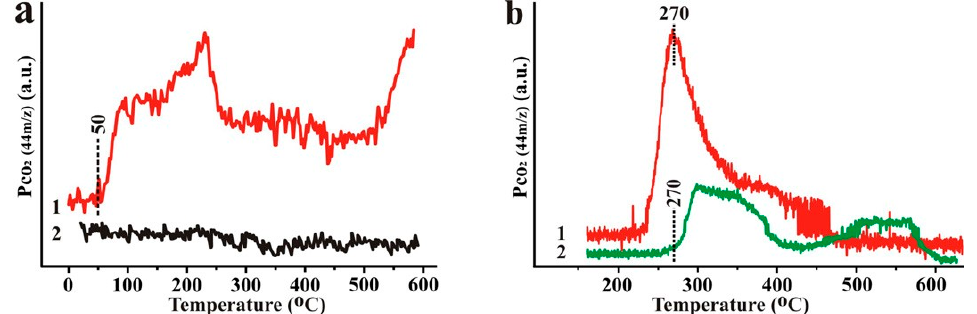
Figure 11. CO TPR profiles for the Ag- ( a ) (1—Ag/SiO 2 , 2—Ag/5_P 2 O 5 /SiO 2 ) and Cu-containing ( b ) (1—Cu/SiO 2 , 2—Cu/30_P 2 O 5 /SiO 2 ) model systems. Reprinted with permission from reference [87]. Copyright 2013 Elsevier.